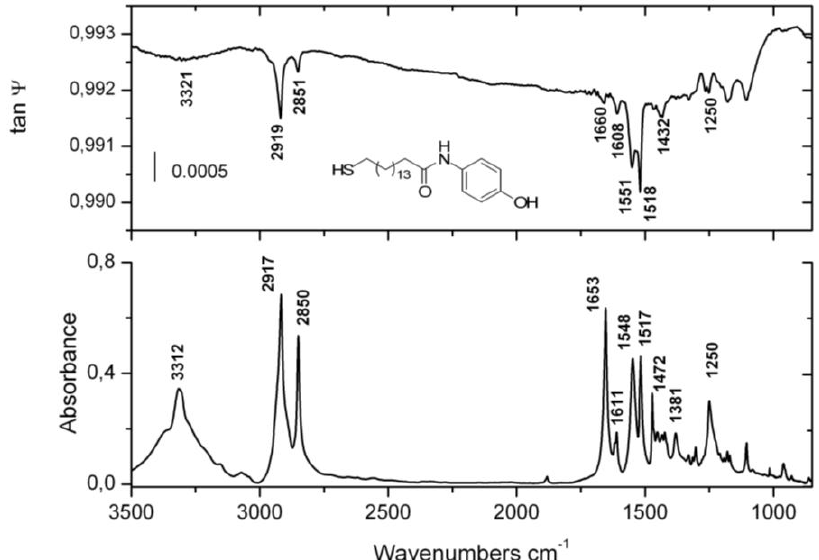
Figure 1. (Top) IR tan  ellipsometric spectrum of 5a monolayer on Au(111), measured at 70  angle of incidence and spectral resolution of 4 cm −1 . (Bottom) IR absorption spectrum of the bulk compound in KBr. All IR absorption spectra were measured at sample concentration 1 mg:300 mg